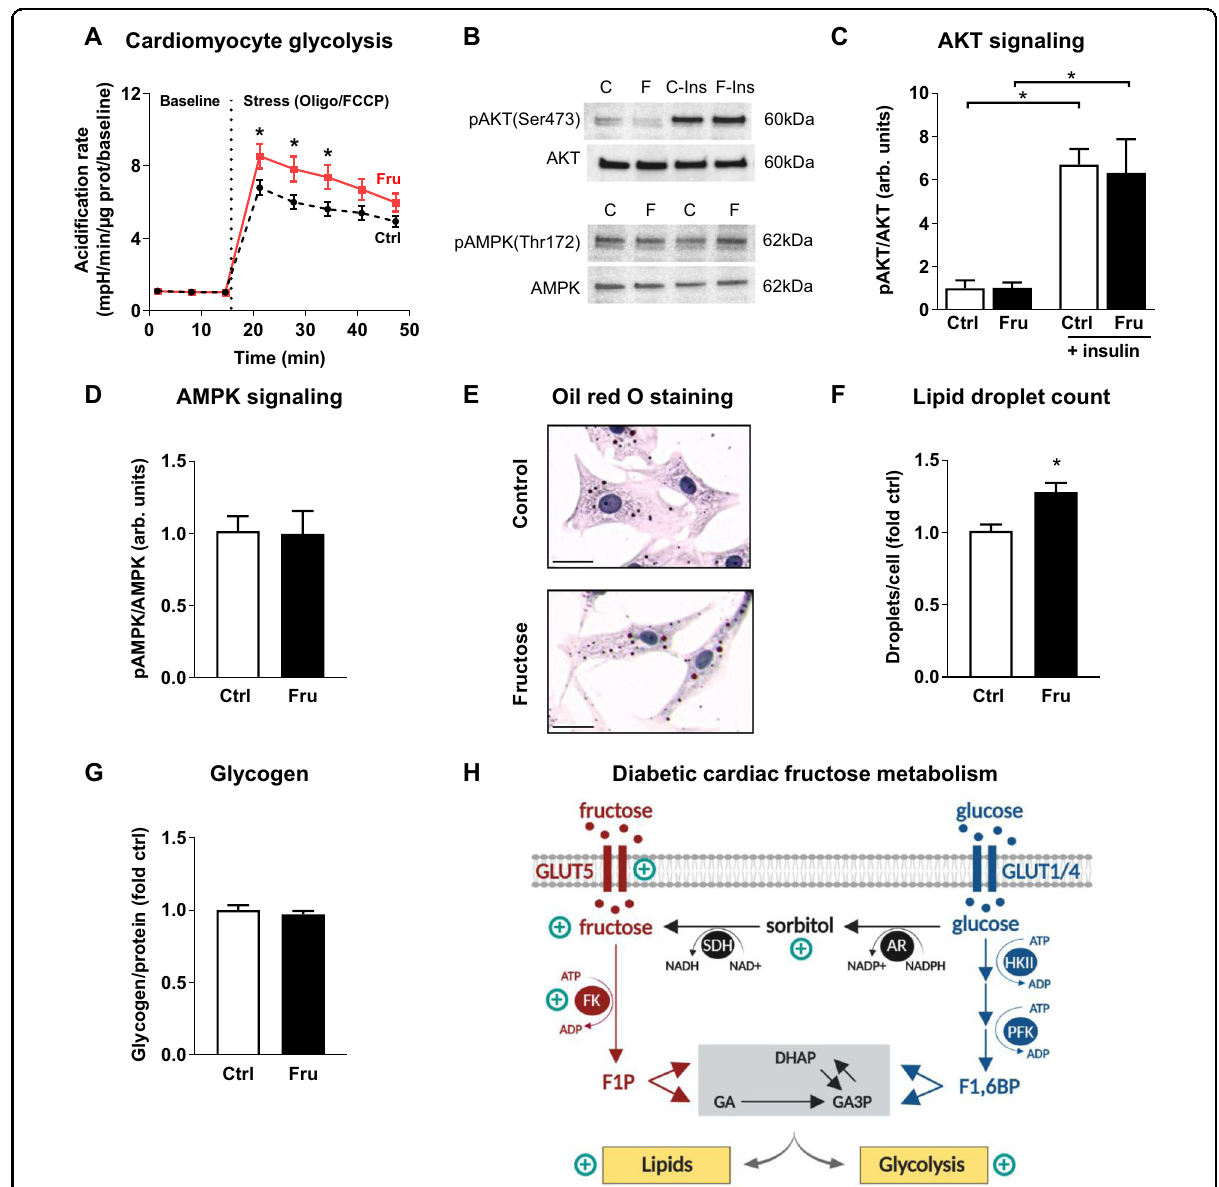
Fig. 2 Effect of fructose on cardiomyocyte glycolysis, energy signaling, lipid droplets, and glycogen content in vitro. Neonatal rat ventricular myocytes were cultured for 24 h with 1 mM fructose (Fru) vs. control (Ctrl, 1 mM mannitol). A Increased glycolytic capacity with fructose was evident during the stress test (extracellular acidi fi cation rate normalized to protein & baseline). Oligo, oligomycin; FCCP, carbonyl cyanide-p- tri fl uoromethoxyphenylhydrazone. n = 9 wells/group, 3 independent cultures. B Representative immunoblots for C , D (C, control; F, fructose; Ins, insulin). Images have been cropped for concise presentation. C Ratio of phosphorylated (Ser473) to total AKT was unchanged with fructose in baseline and insulin-stimulated conditions (1 µm insulin, 30 min). D Ratio of phosphorylated (Thr172) to total AMPK was unchanged with